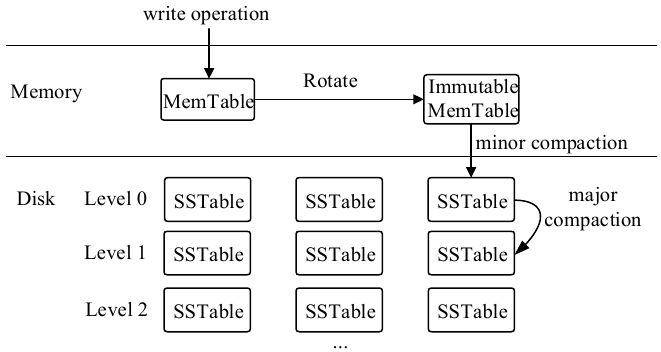
Figure 1. Basic structure of an LSM-tree.